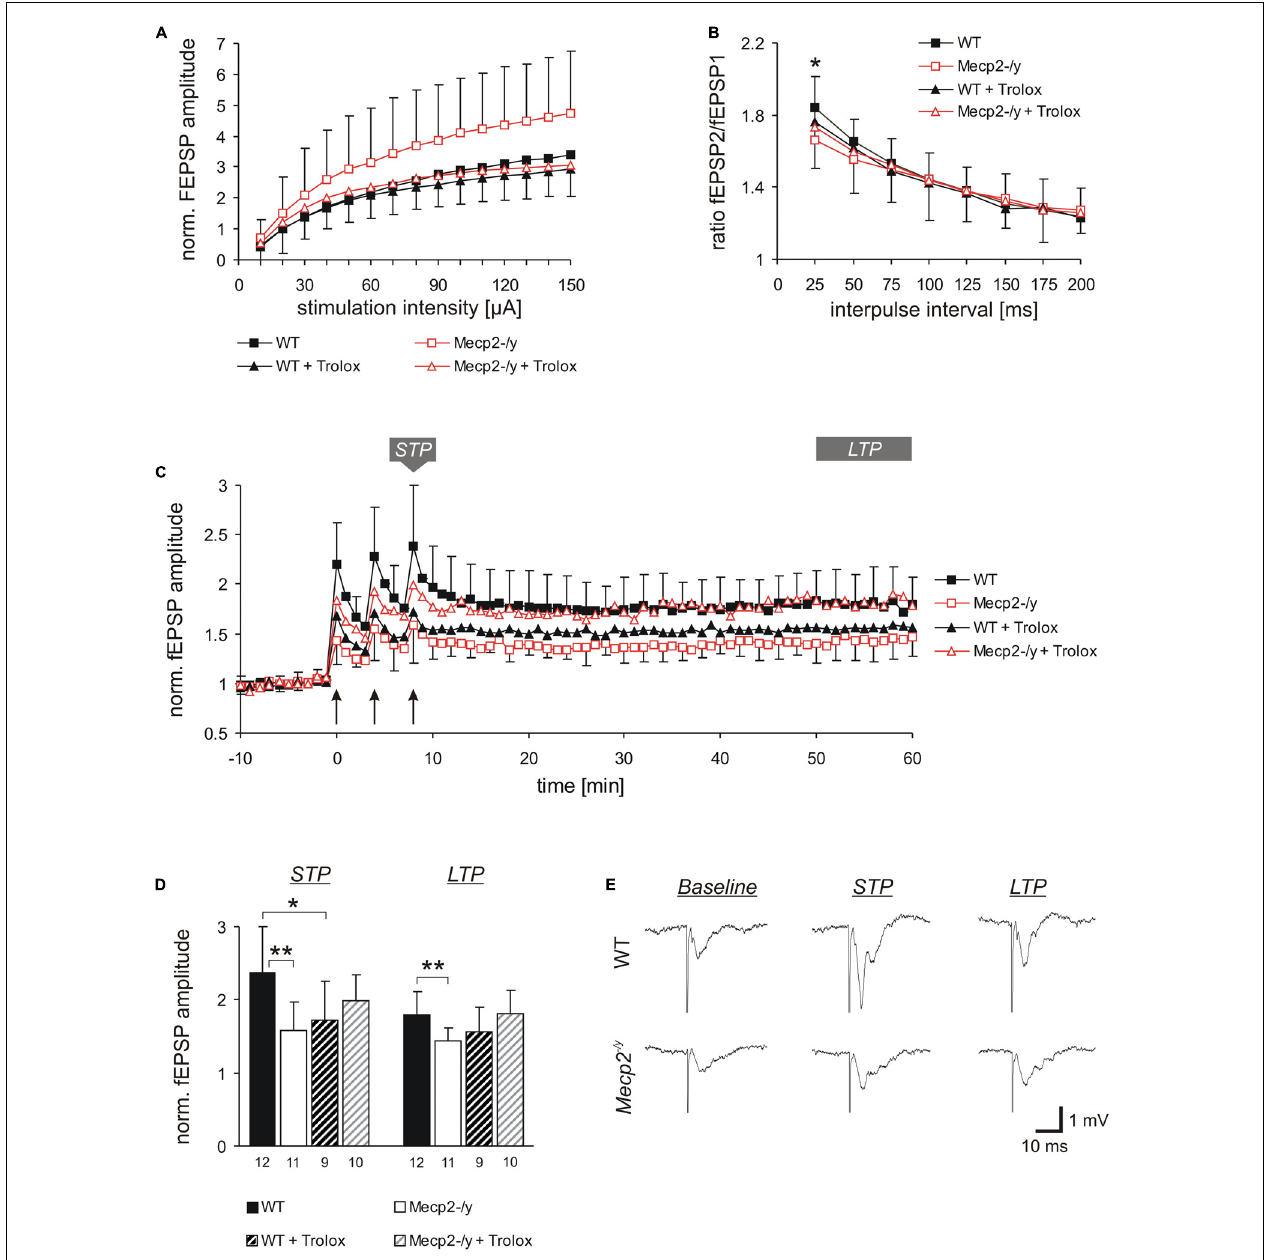
FIGURE 1 |Trolox dampens neuronal hyperexcitability and reinstates LTP in Mecp2 − / y hippocampus. (A) Input-output curves showing a significantly increased excitability in Mecp2 − / y slices as compared to WT at all stimulation intensities (10–20 μ A P < 0.05; 30–60 μ A P < 0.01, 70–150 μ A P < 0.001). Trolox (1 mM, 3–5h) abolished this genotypic difference. The plotted fEPSP amplitudes are normalized to the fiber volley of the respective slice. Displayed are the averages of 37–50 slices, and error bars represent standard deviations; for clarity they are shown for Mecp2 − / y and Mecp2 − / y plus Trolox only. (B) Paired-pulse facilitation (PPF), a measure of short-term plasticity, was less pronounced in Mecp2 − / y than in WT slices for the shortest interpulse-interval tested. Trolox abolished this genotypic difference, but otherwise did not mediate any noticeable effects. Plotted are the averages of 35–52 slices; asterisks indicate statistically significant changes among WT and Mecp2 − / y slices